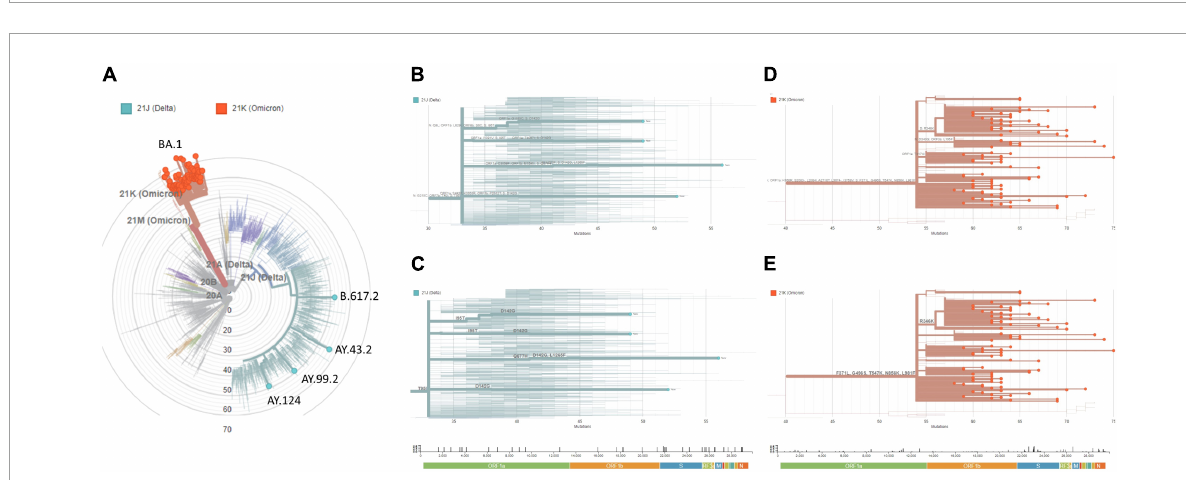
FIGURE2 Genomic surveillance links uprising cases to Omicron VoC. From the cohort of SARS-CoV-2 positive samples, 95 were randomly chosen for targeted next-generation sequencing (ATOPLEX SARS-CoV-2 panel v2.0, MGI Tech Co.) and genomic analysis. (A) Maximum-Likelihood phylogeny of the isolated genome consensus sequences and publicly available datasets under NextClade v.1.5.1. (B) Diagram of mutations across the genome, or (C) restricted to the Spike gene, in cases associated with the Delta variant (clade 21J). (D) Diagram of mutations across the genome, or (E) restricted to the Spike gene, in cases associated with the Omicron variant (clade 21K). Genetic diversity (entropy panel) across the genome, whose components are color-coded, are represented below the diagrams. The genome consensus sequences isolated in this study were deposited at GISAID (https://www.gisaid.org; EPI_ISL_11627542 to EPI_ISL_11627636) and GenBank (https://www.ncbi.nlm.nih.gov/genbank; ON241656 to